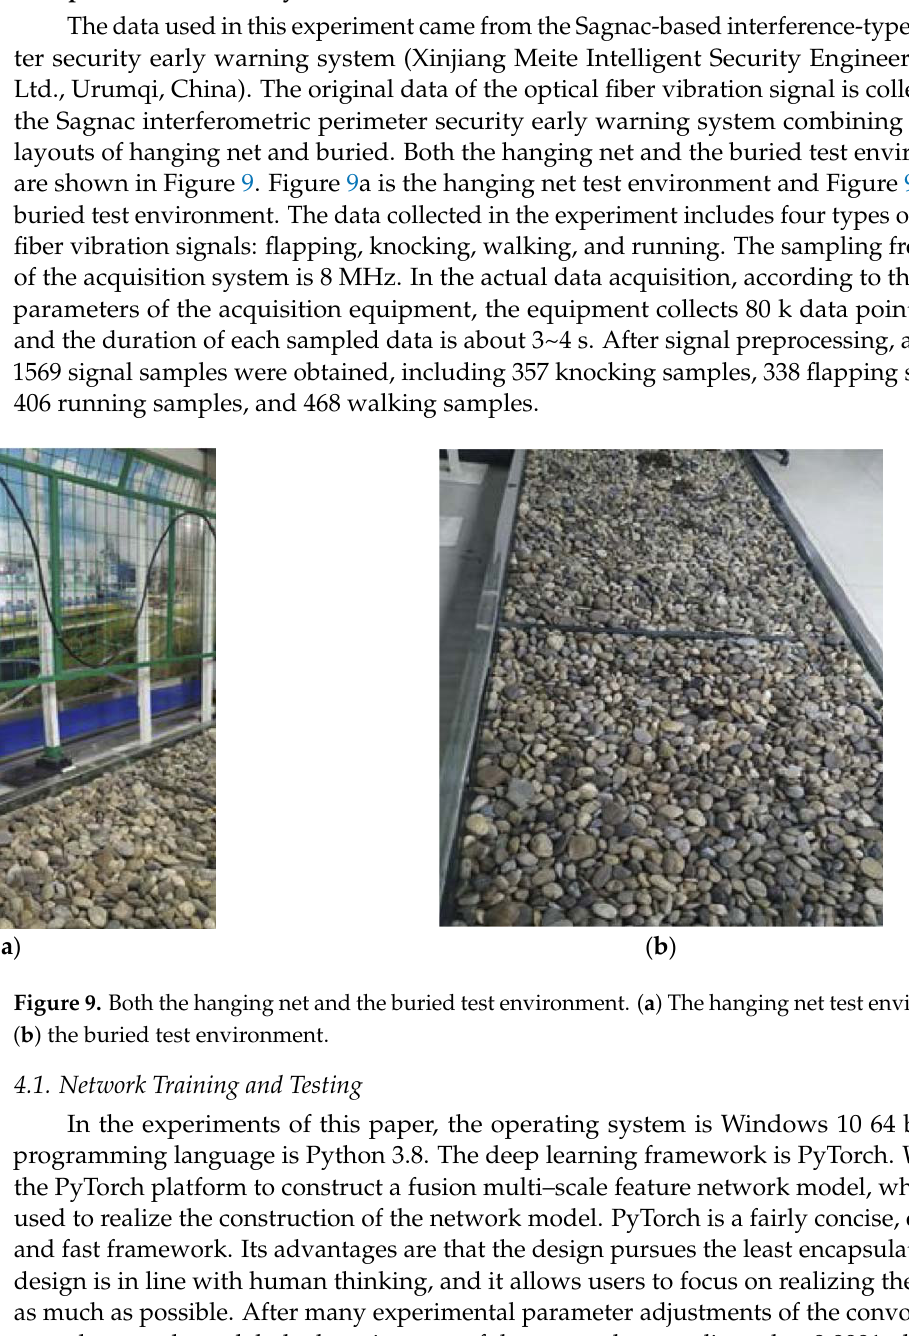
Figure 8. Differential pooling structure.